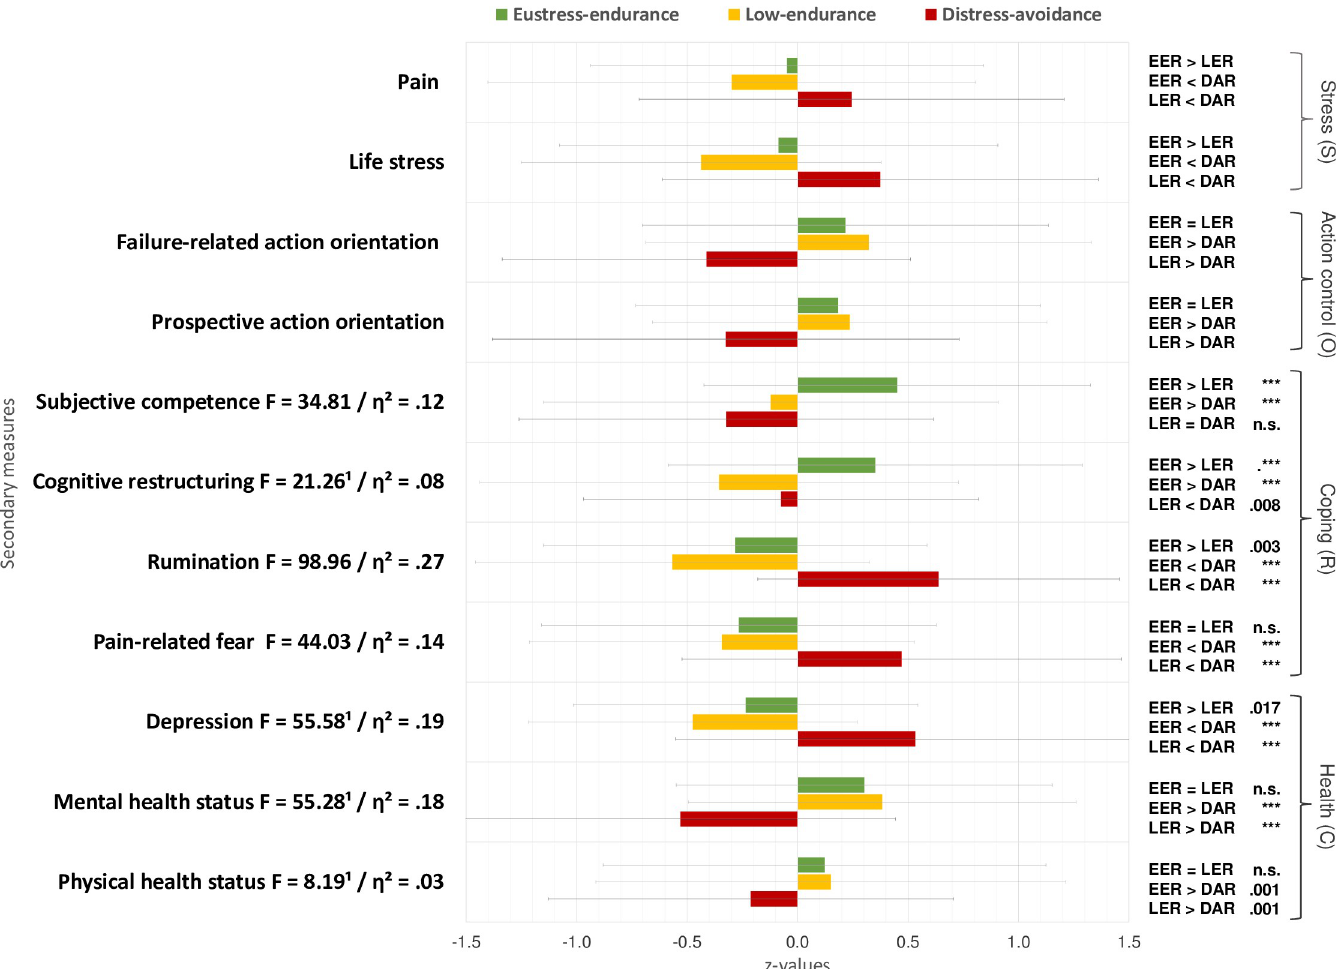
Fig 2. Z-standardized means, standard deviations, overall (ANOVAs) and pairwise mean comparisons of pain response profiles on secondary measures. Note: EER = Eustress-endurance, LER = Low-endurance, DAR = Distress-avoidance responders; 1 = Welsh test; all overall p < .001; ��� = p < .001; η 2 classification of effect sizes by Cohen [88]: η 2 = .01, small, η 2 = .06, medium, η 2 = .14, large